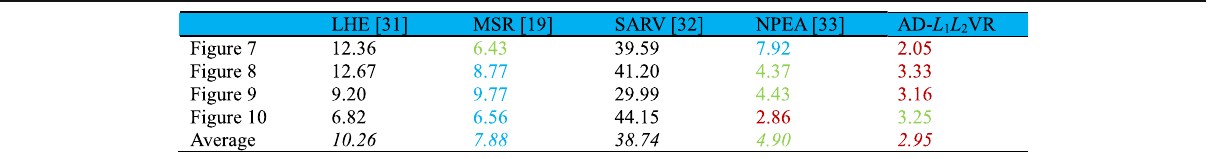
Table 3 LOE values of compared methods